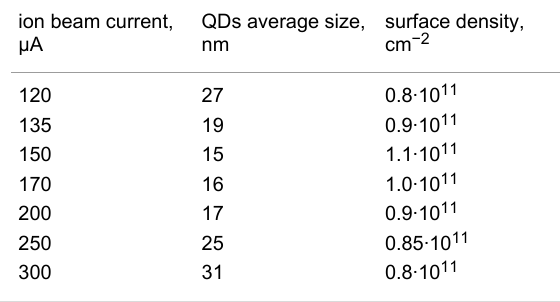
Table 3: Average size and surface density of QDs as a function of the ion